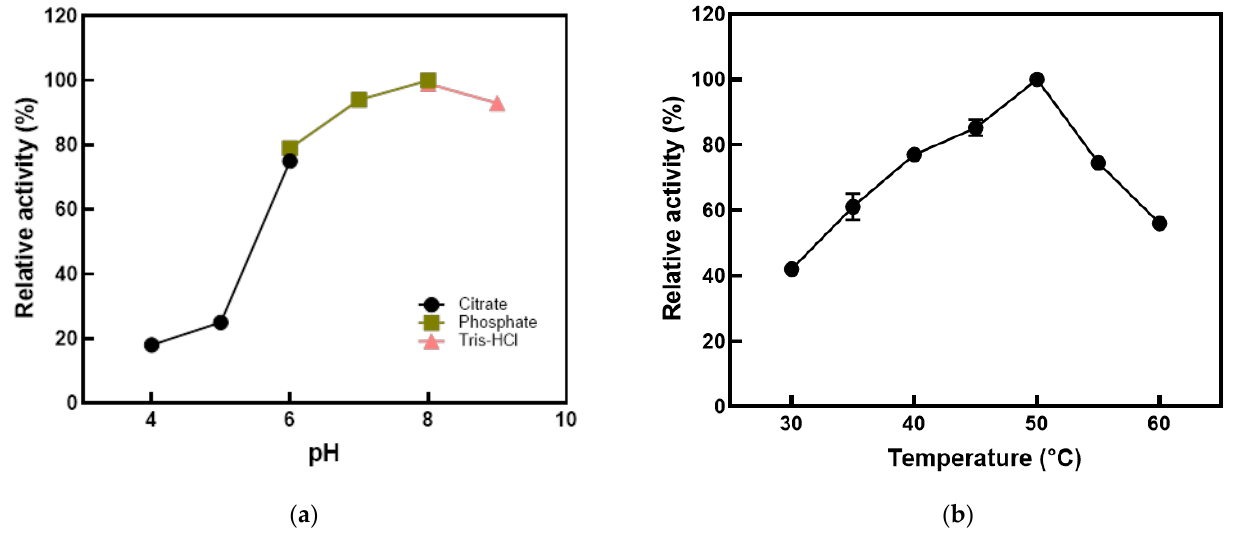
Figure 4. Investigation of pH and temperature to optimize the production of D -tagatose from D -galactose by E. coli cells expressing L -arabinose isomerase from K. pneumoniae . ( a ) Investigation of pH. The reactions were performed in 50 mM citrate (pH 4.0–6.0), phosphate (pH 6.0–8.0), and Tris-HCl (pH 8.0–9.0) buffers containing 20 g/L D -galactose and 1 g/L cells at 40 °C for 10 min. ( b ) Investigation of temperature. The reactions were performed in 50 mM phosphate buffer (pH 8.0) containing 20 g/L D -galactose and 1 g/L cells at different temperatures, ranging from 30 °C to 60 °C for 10 min. Data represent the mean of values from three experiments, and error bars represent standard deviation.